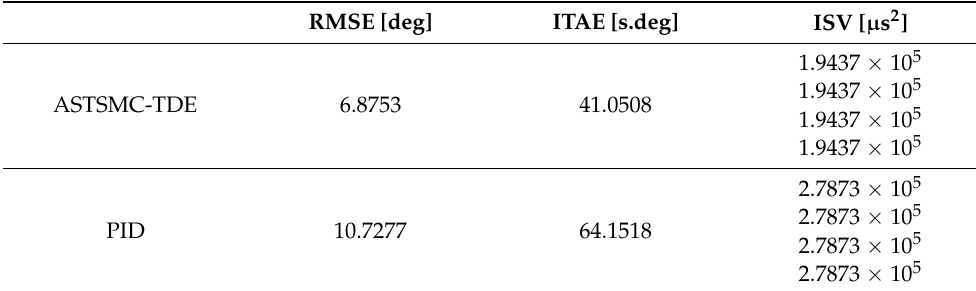
Table 4. RMSE, ITAE, and ISV experimental values in NM